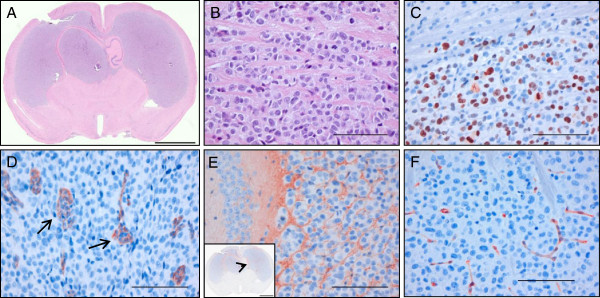
Phenotypic characteristics of the IDH1 mutant xenograft model. Low (A) and high (B) magnifications of H&E-stained sections of E478 xenografts in mouse brain, showing diffuse infiltration throughout both hemispheres (note that infiltrative strands of cancer cells are interspersed in white matter [B]). C) Ki-67 staining resulted in a proliferation index of approximately 34%. D) Immunohistochemical anti-CD34 staining shows abundant presence of florid microvascular proliferations. E) Immunostaining of mouse IgG shows limited and focal leakage of IgG from the tumor vasculature. The arrowhead in the low-magnification inset indicates the area depicted. F) Blood vessels in the tumor express GLUT-1 that is characteristic for endothelial cells forming the blood–brain barrier. Cancer cells do not express GLUT-1, indicating that the tumor is not hypoxic. Size bars in A: 1 mm, B-F 100 μm.